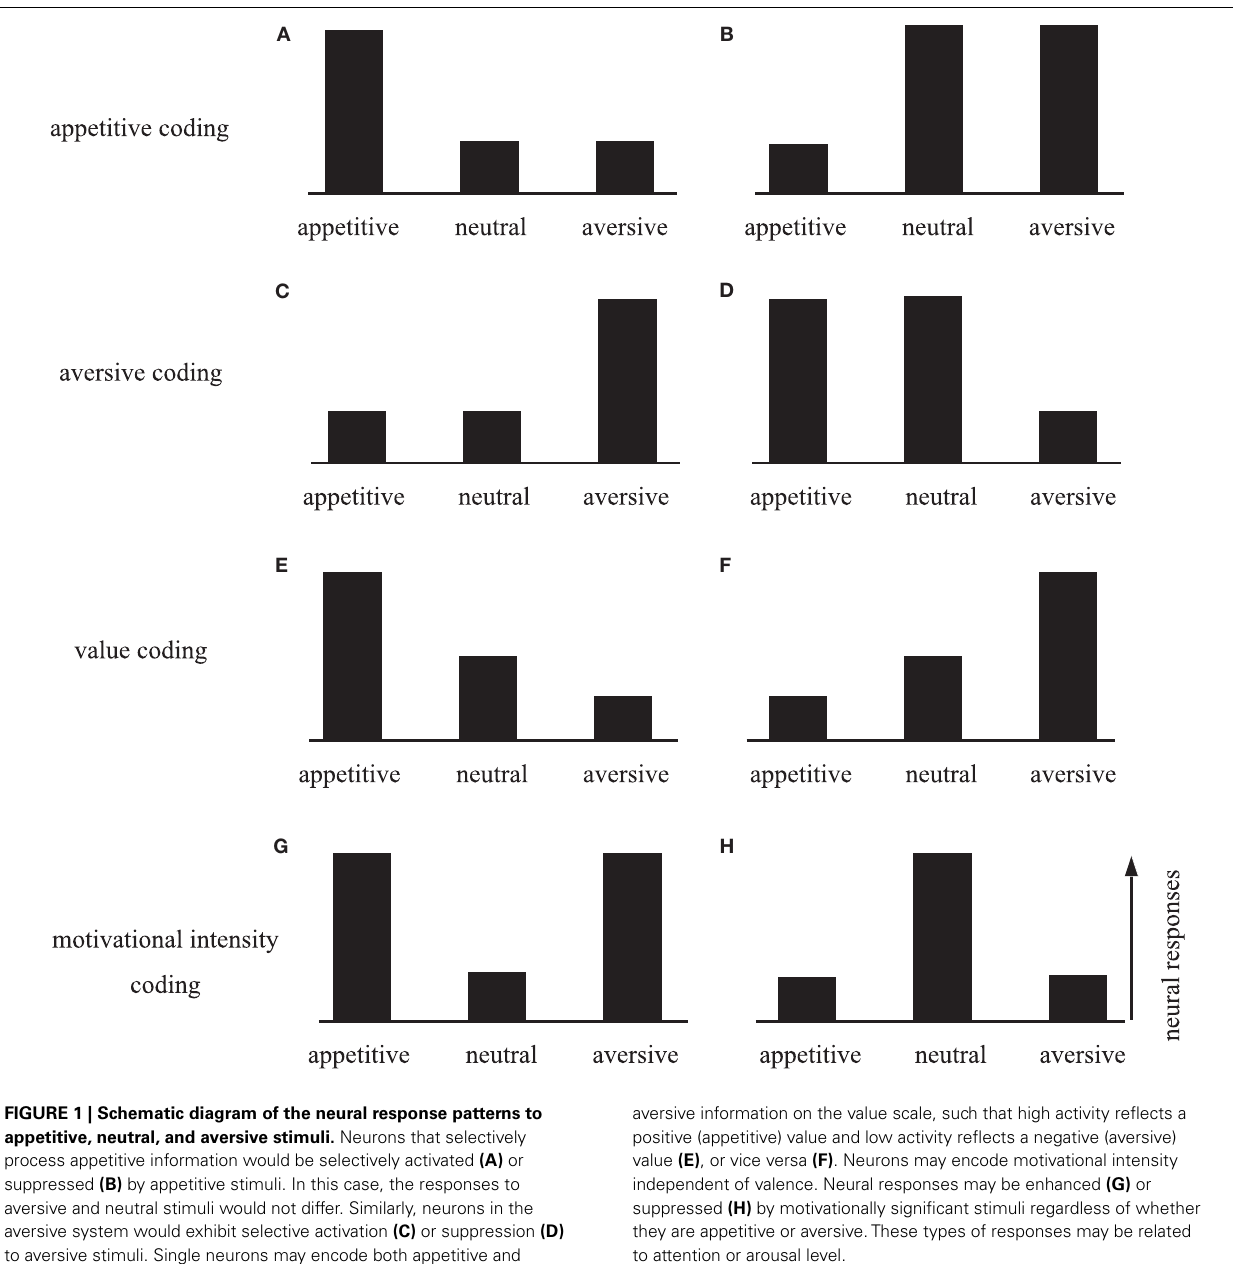
aversive information on the value scale, such that high activity reflects a positive (appetitive) value and low activity reflects a negative (aversive) value (E) , or vice versa (F) . Neurons may encode motivational intensity independent of valence. Neural responses may be enhanced (G) or suppressed (H) by motivationally significant stimuli regardless of whether they are appetitive or aversive.These types of responses may be related to attention or arousal